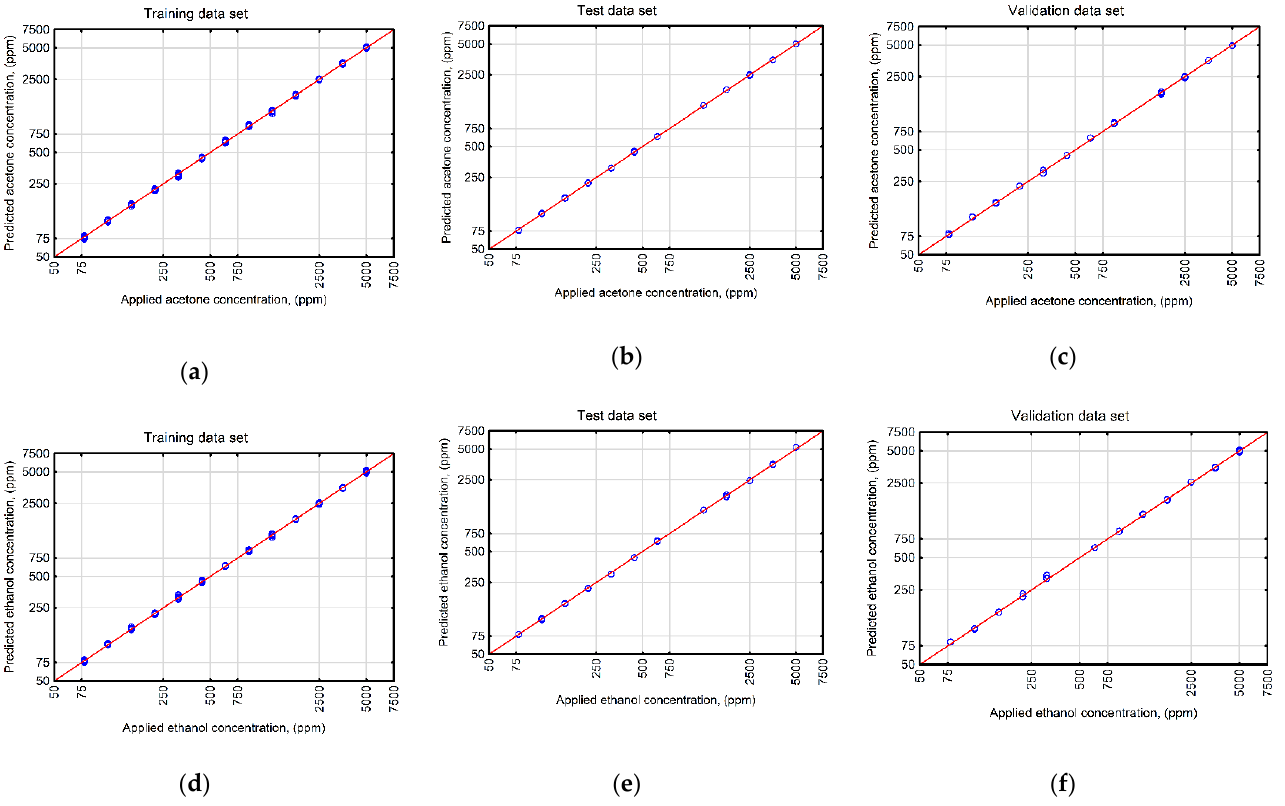
Figure 7. A comparison of analyte concentrations (ethanol and acetone) applied in experiments and estimated with the ANN E-A model for ( a ) learning, ( b ) test, ( c ) validation data sets recorded for acetone and ( d ) learning, ( e ) test, ( f ) validation data sets recorded for ethanol.